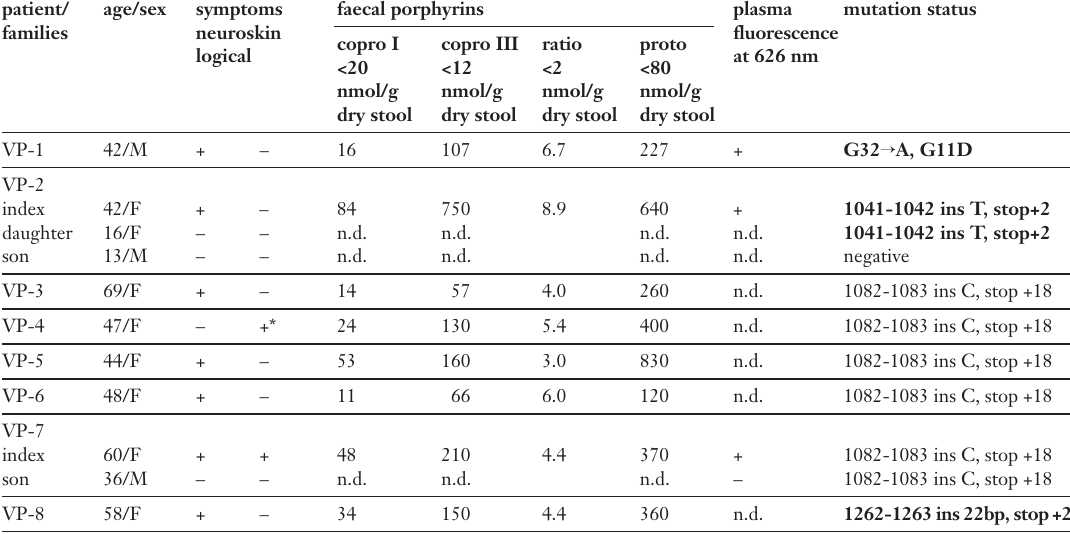
Clinical, biochemical and mutation data of Swiss VP patients/